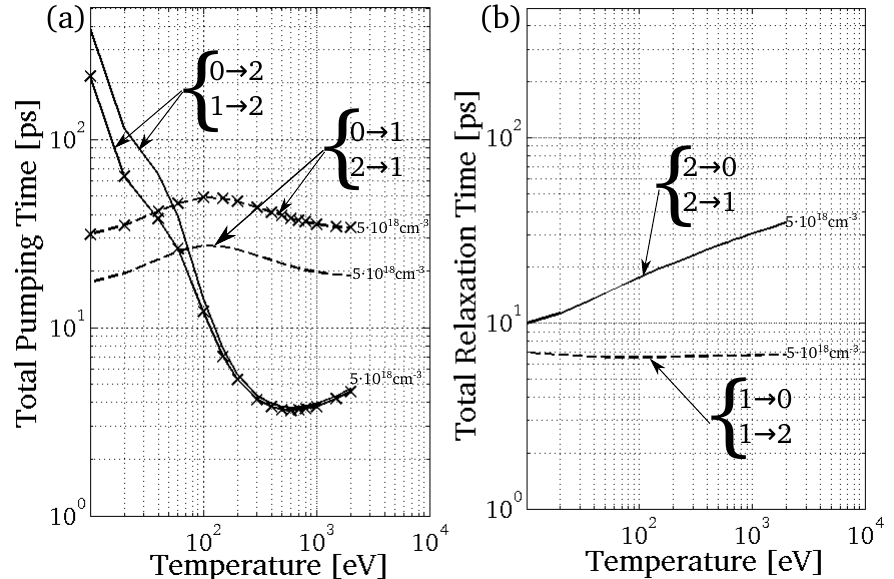
Figure 7. ( a ) Total pumping time (Equation (14a)) to the upper level (2) and lower level (1) at an electron density of 5 · 10 18 cm − 3 , considering an inversion factor of 10% (curve with marker) and 50% (curve without marker). ( b ) Total relaxation time (Equation (14b)) of the upper (solid line) and lower (dashed line) levels of Ne-like Ar +8